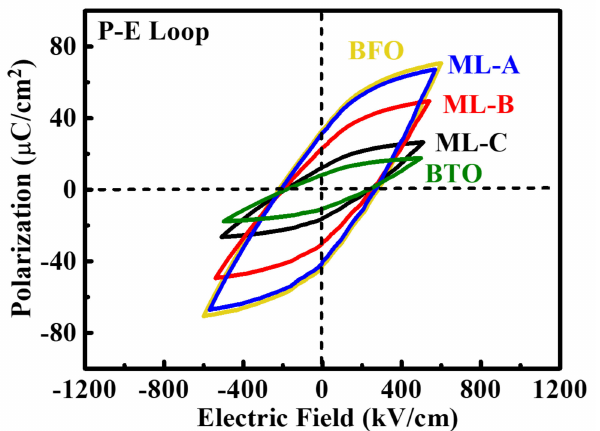
Figure 4. The plots of the Polarization-Electric field (P-E) curves for the pure 100 nm BaTiO 3 (BTO) thin film, the pure BiFeO 3 (BFO) thin film, and our designed multi-layer (BaTiO 3 (BTO)/BiFeO 3 (BFO)) structures from Condition A (ML-A) to Condition C (ML-C).